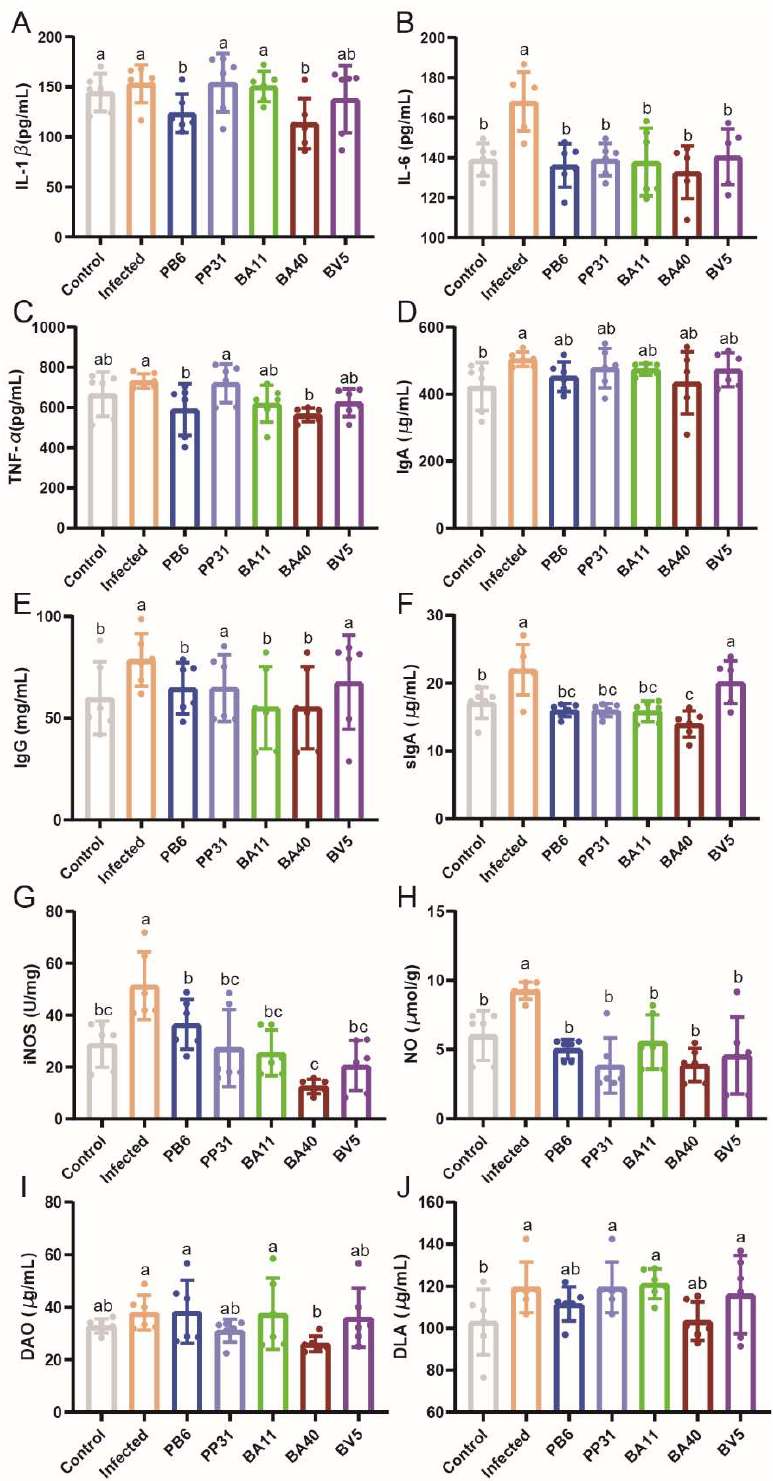
Figure 8. The effect of isolated probiotics treatment on inflammatory cytokines, immunoglobulin, DAO and DLA in mice. ( A ) IL-1β concentrations. ( B ) IL-6 concentrations. ( C ) TNF-α concentrations. ( D ) IgA concentrations. ( E ) IgG concentrations. ( F ) sIgA concentrations. ( G ) iNOS concentrations. ( H ) NO concentrations. ( I ) DAO concentrations. ( J ) DLA concentrations. Results are presented as mean ± SD. a, b, c, d Means values with dissimilar letters were significantly different ( p < 0.05). All values contained six